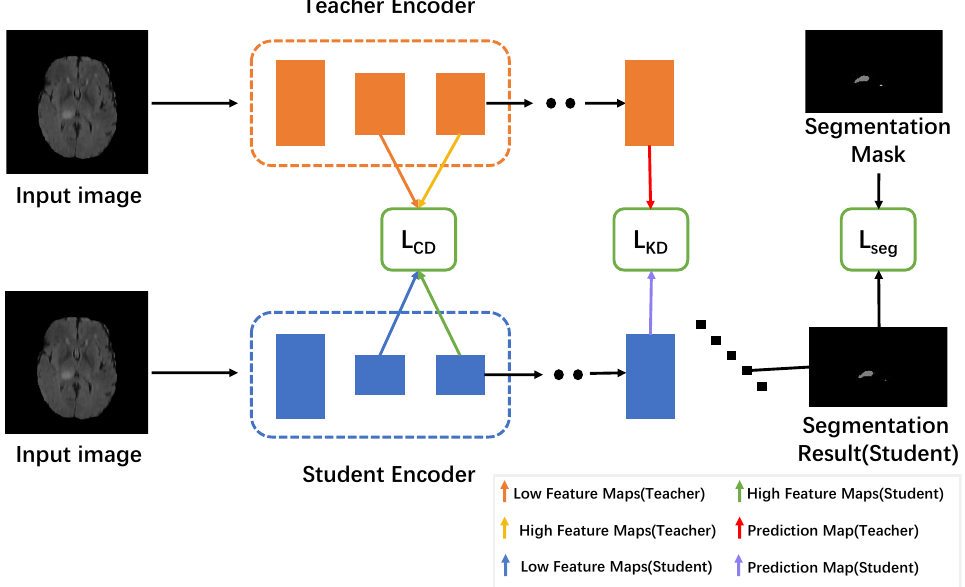
Figure 1. The proposed knowledge distillation architecture. The orange box represents the teacher network, and the blue box represents the student network. They obtained the same image as input. The green box between the two networks, from left to right, is the coordinate distillation (CD) module and the knowledge distillation (KD)